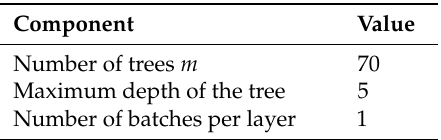
Table 1. Parameter setup for training the matching